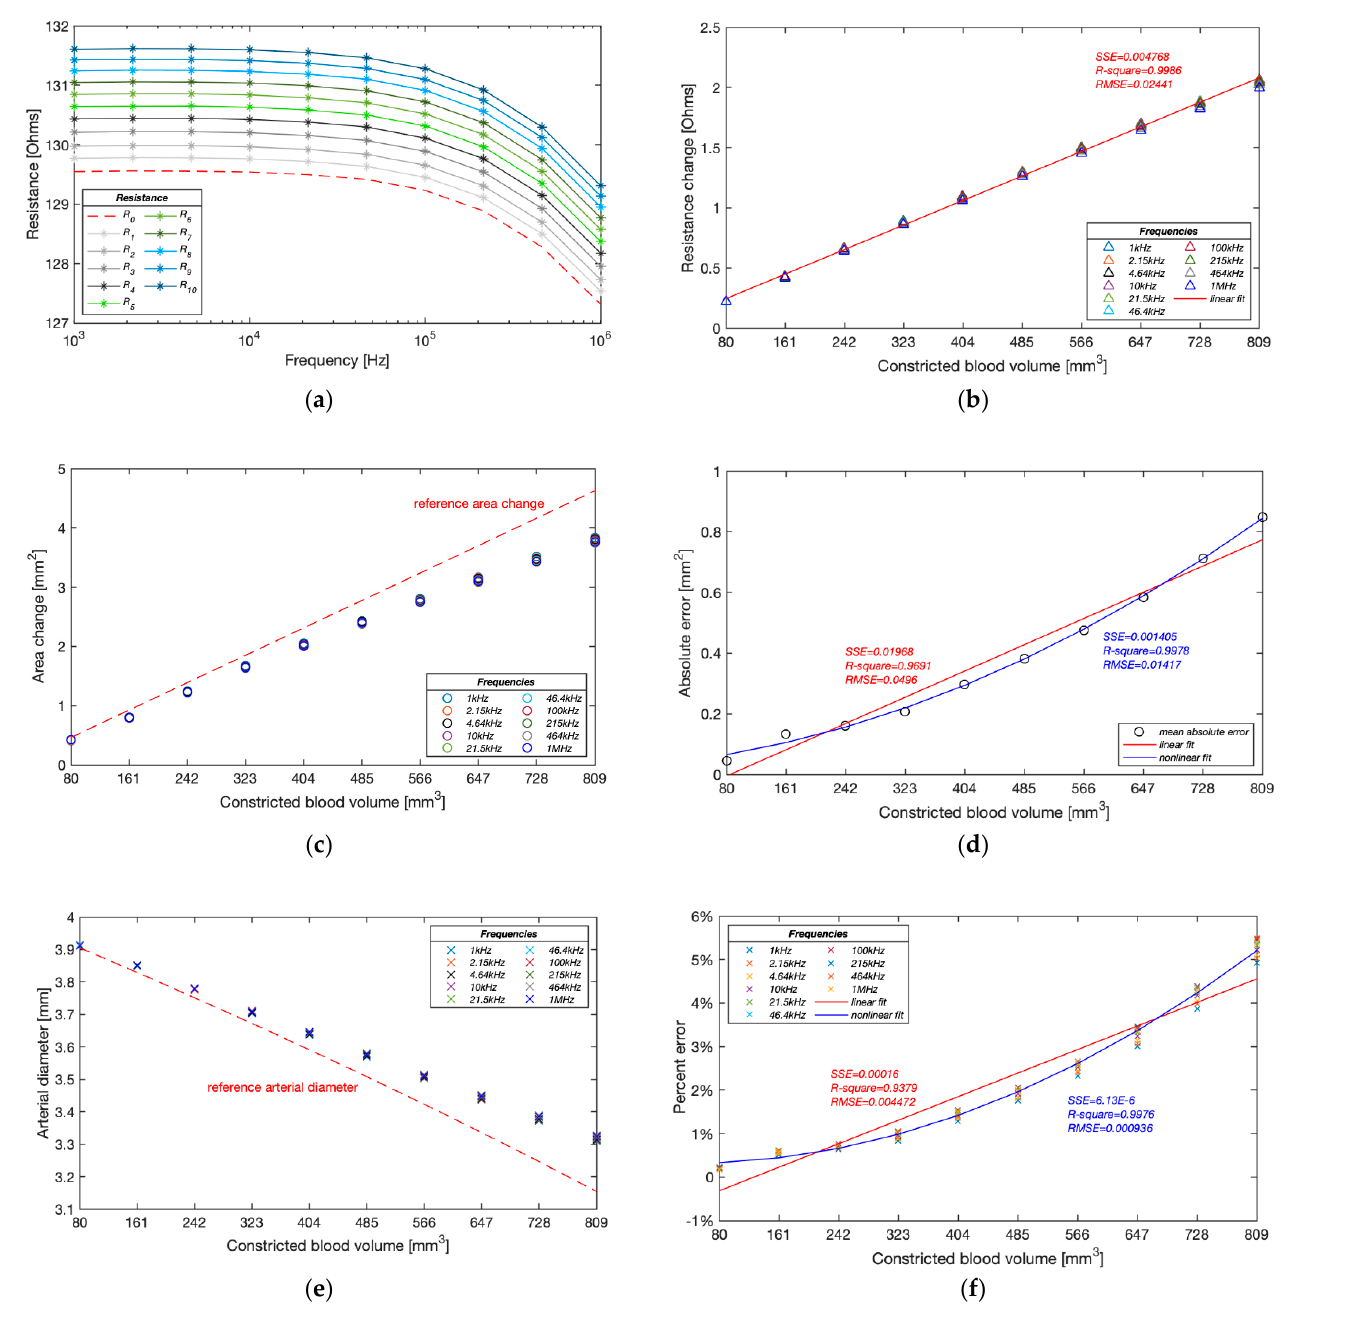
Figure 16. Experimental results of Group B: ( a ) measured resistance with ten pumping times; ( b ) measured resistance change during pumping; ( c ) estimated cross-sectional area change of the artery during pumping; ( d ) average absolute errors of estimated cross-sectional area change dur- ing pumping; ( e ) estimated arterial diameter during pumping; ( f ) relative errors of estimated arterial